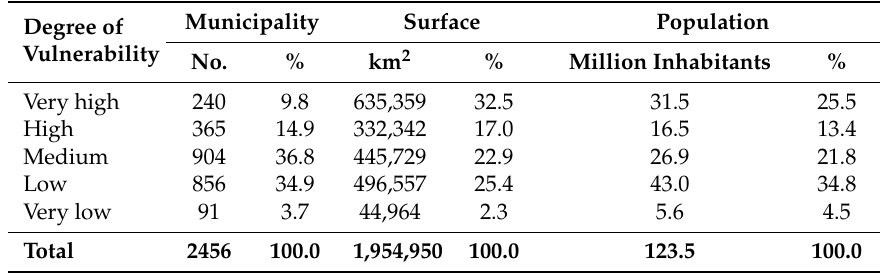
Figure 8. Map of overall vulnerability to drought. Table 12. Distribution of number of municipalities, surface area, and population by degree of overall vulnerability to drought.